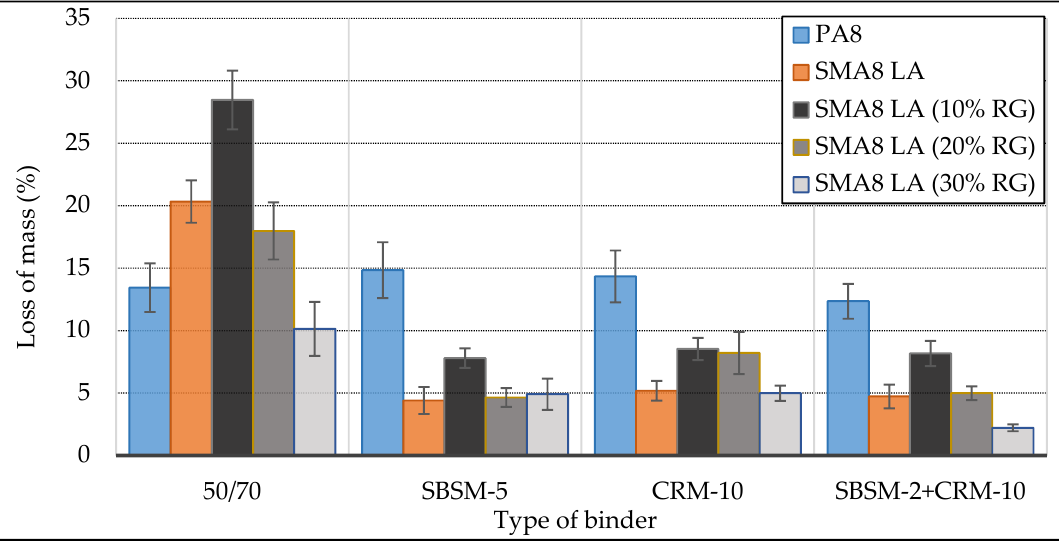
Figure 4. Cantabro test results.